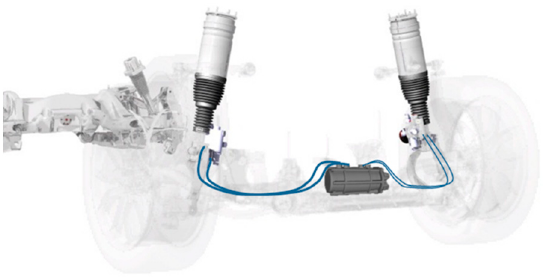
Figure 3. Depiction of the ACOCAR ® hydraulic active suspension system (Tenneco Automotive).